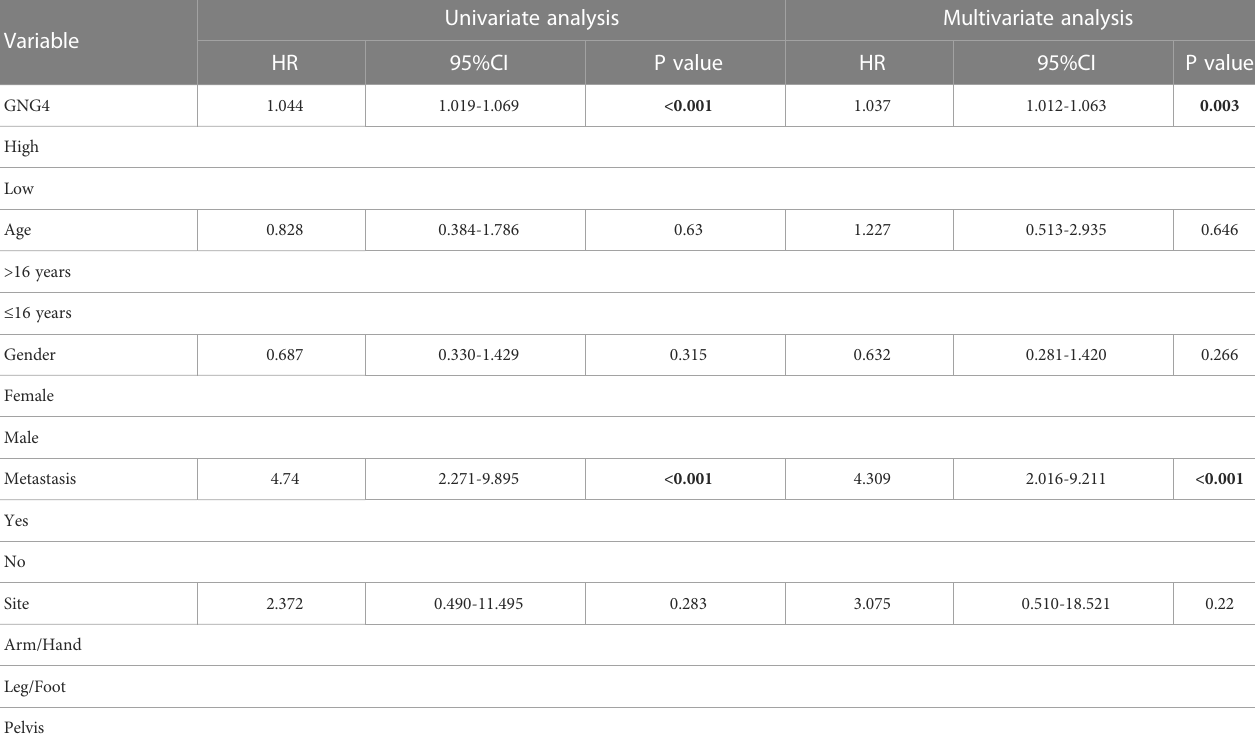
TABLE 2 Univariable and multivariable Cox regression analysis of clinical characteristics and GNG4 in TARGET database.